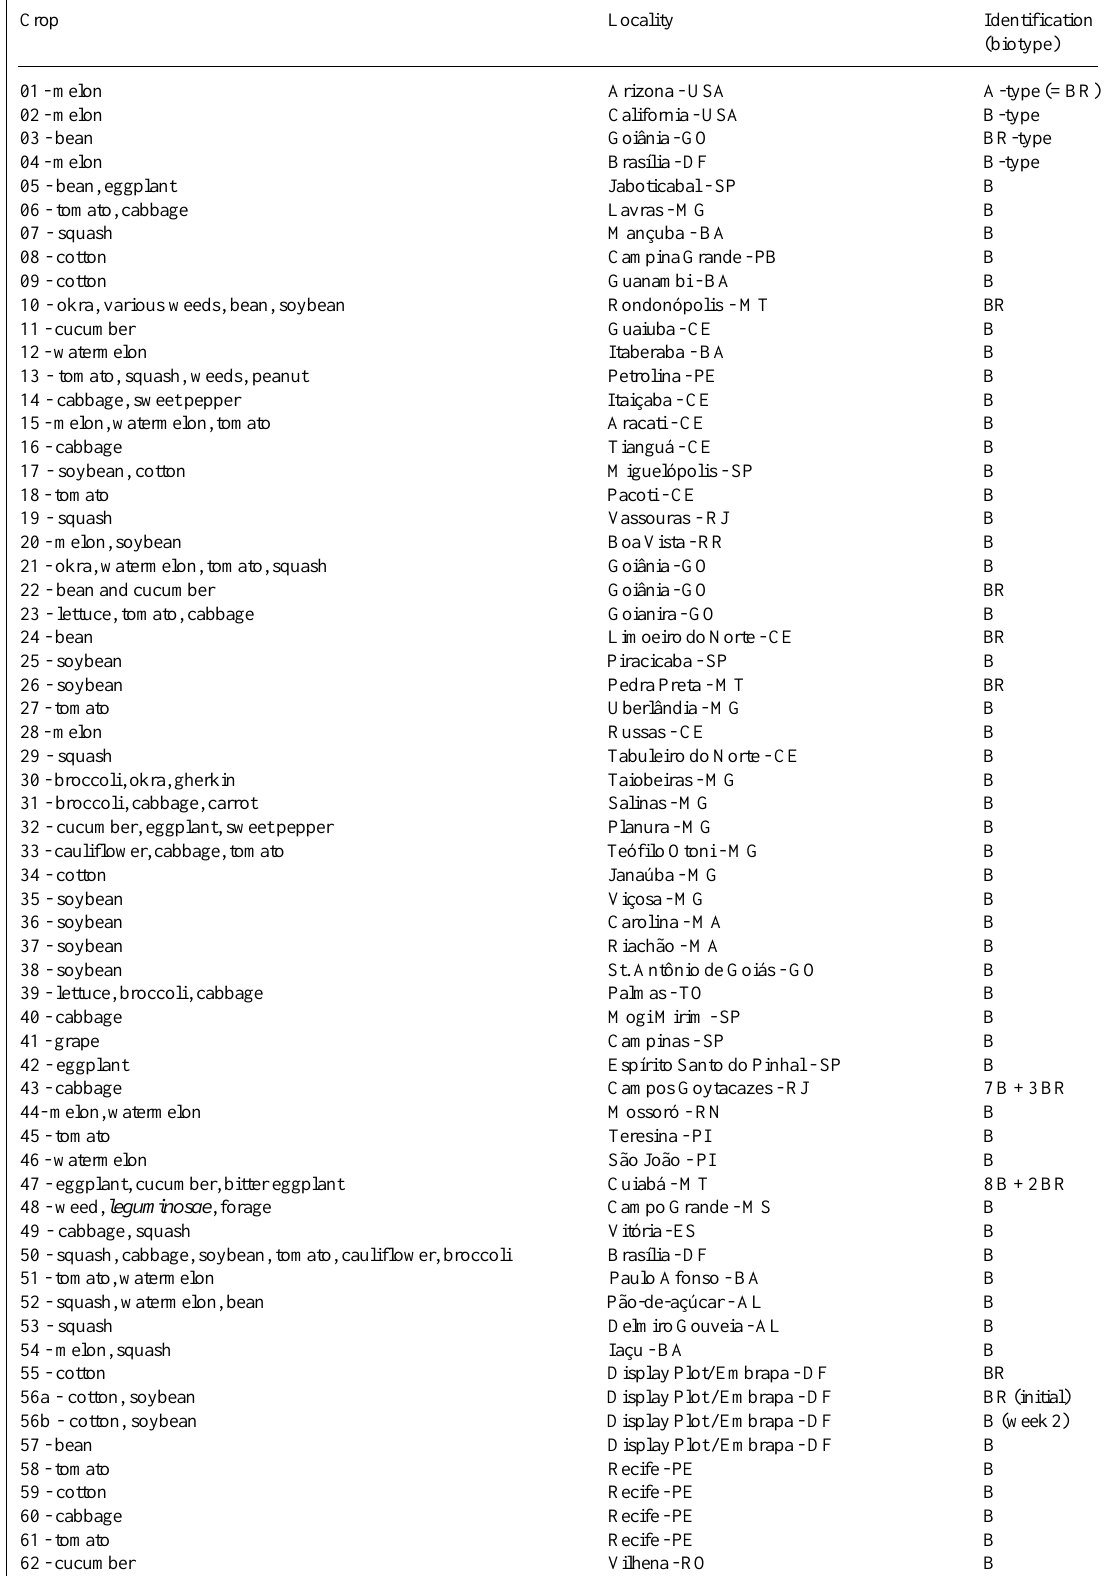
Table 2 - Biotype identification using RAPD markers of Bemisia tabaci sampled from different crops and localities in Brazil.